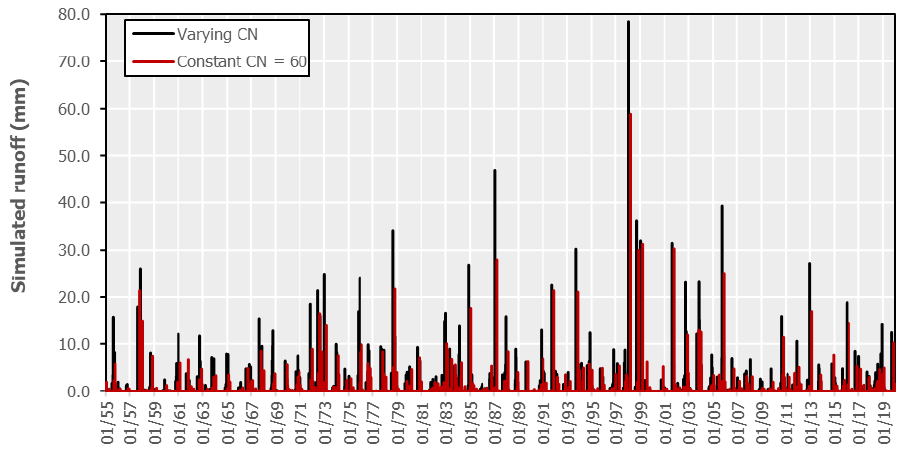
Figure 6. Simulated daily runoff from 1955 to 2019, through the NRCS-CN approach for CN II = 60, by considering constant and varying (adjusted to 60 day rainfall) CN .